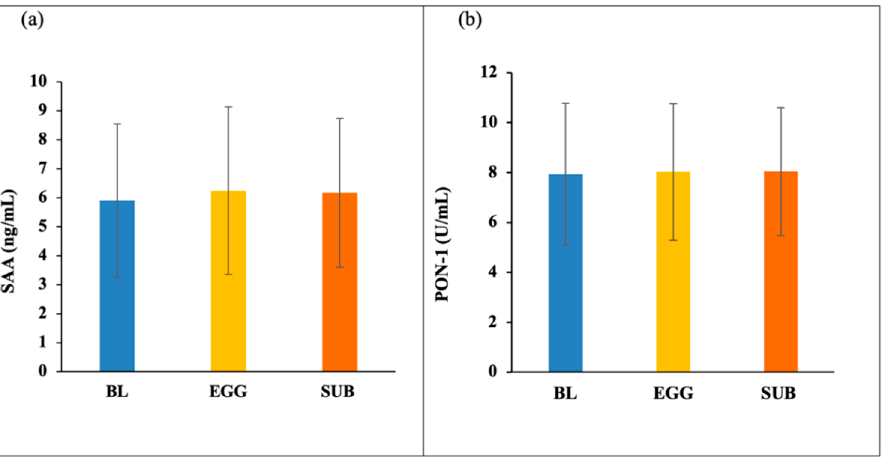
Figure 1. ( a ) Concentration of serum amyloid A (SAA) and ( b ) paraoxonase-1 (PON-1) measured at baseline (BL) and after EGG (whole eggs) and SUB (egg substitute) treatments for n = 24